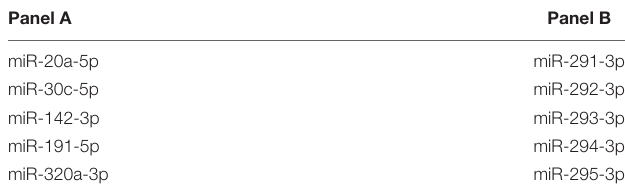
TABLE 1 | Select mature miRNAs comprising panels A and